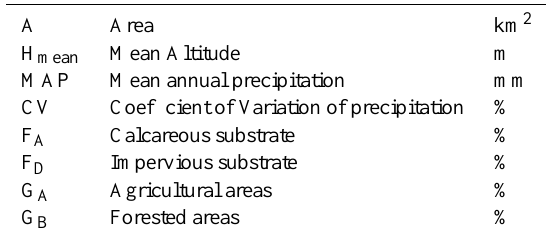
Table 1. Predicting variables and